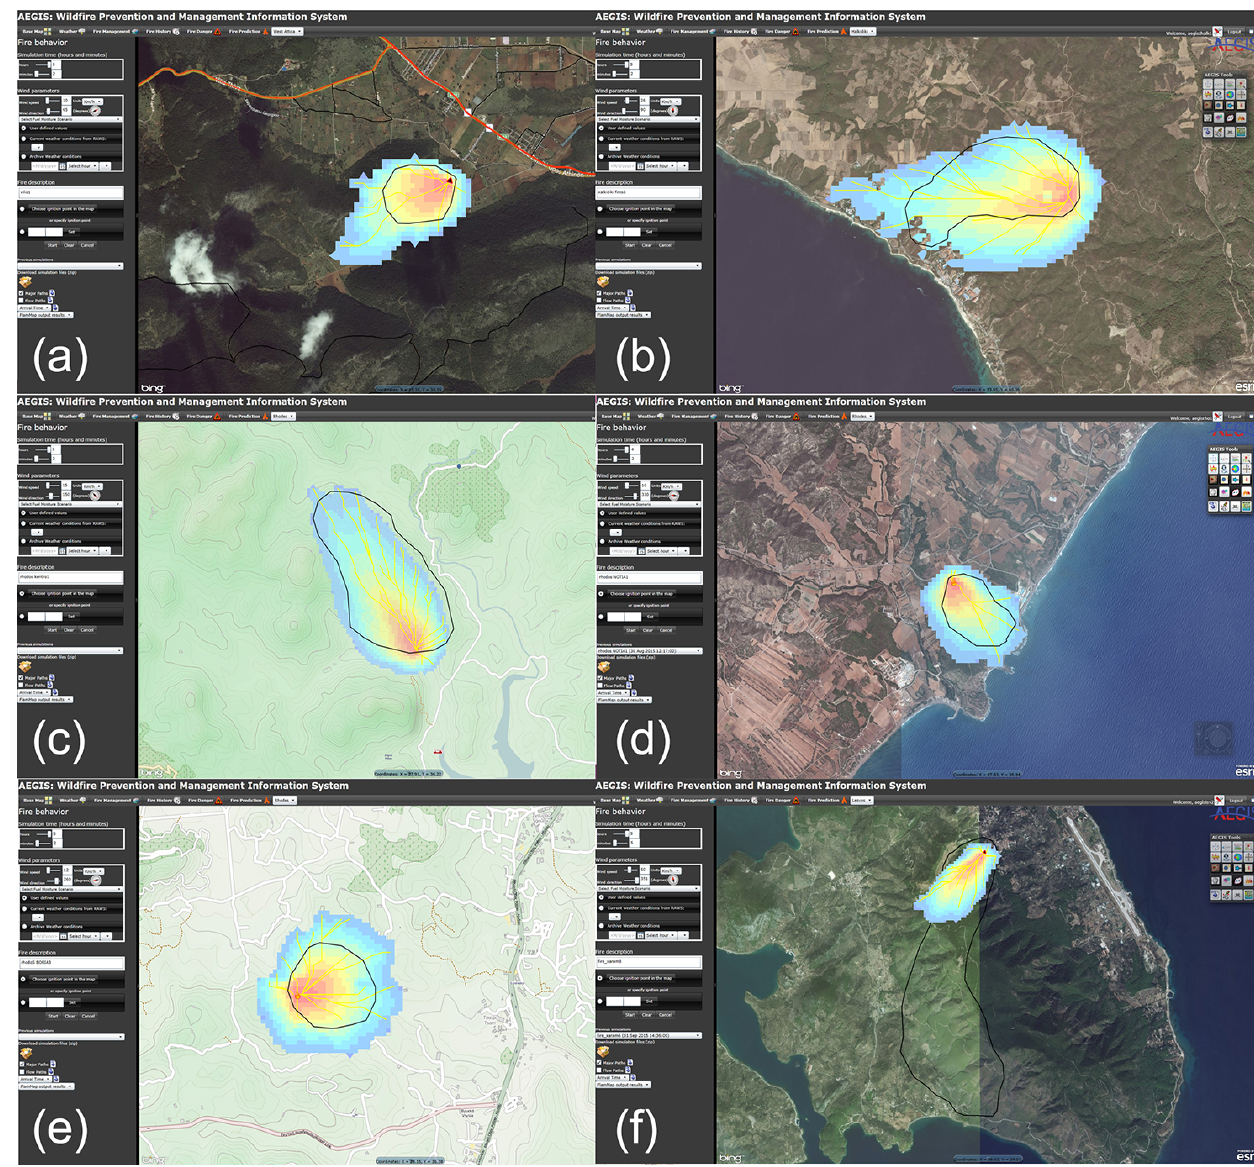
Figure 9. Simulation results of the six actual wildfires that occurred during the summer of 2015 in four of our study areas ( a : West Attica, 13 June 2015, 50ha burned; b : Chalkidiki, 16 June 2015, 150ha burned; c : Rhodes, 23 July 2015, 323ha burned; d : Rhodes, 31 July 2015, 50ha burned); e : Rhodes, 23 August 2015, 77ha burned; and f : Lesvos, 30 August 2015, 550ha burned) – black polygons delimit the actually burned areas, while colored areas and lines map times of arrival and major travel paths in